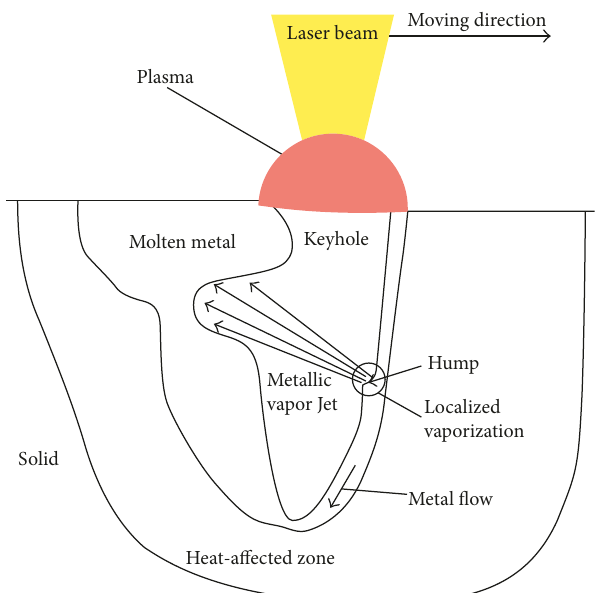
Figure 1: A cross-sectional schematic of a side view (the interface between two solids) of the melt-pool formed during a laser welding